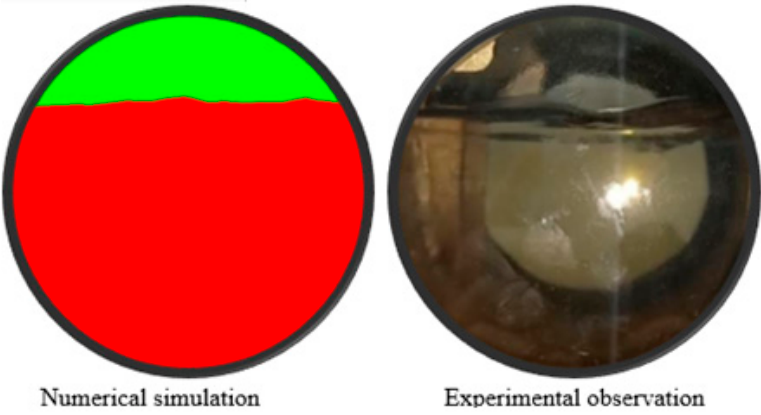
Figure 8. The flow pattern in the optical window according to the experimental observation and numerical simulation.